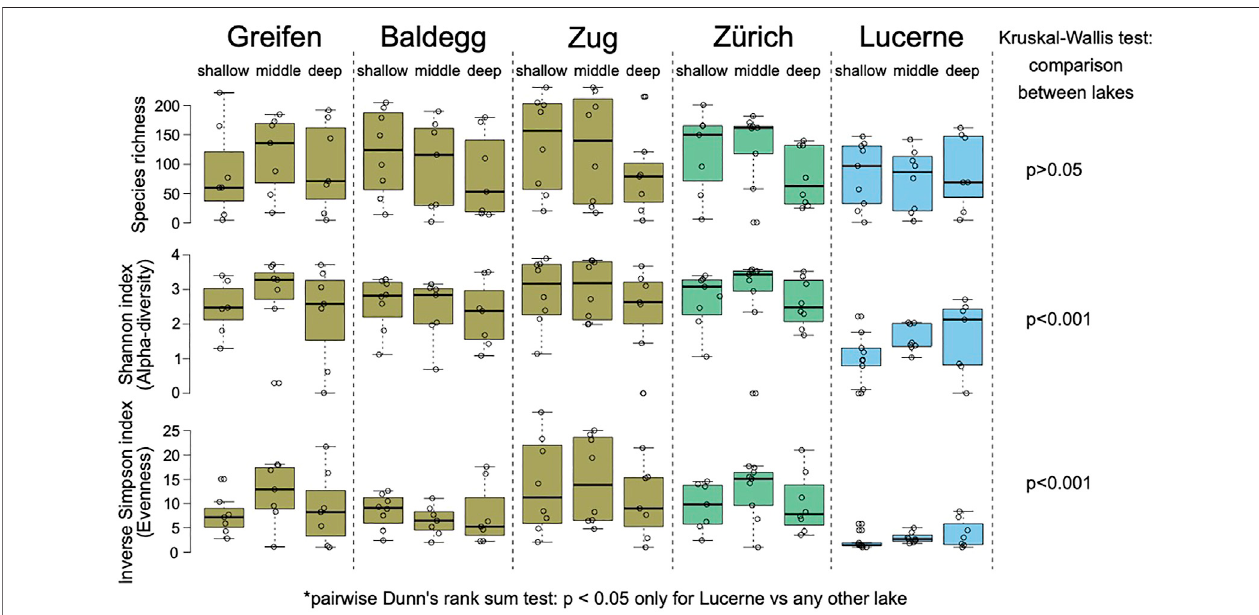
FIGURE4| OTURichness(totalnumberofOTUs),ShannonIndex(diversity),andInverseSimpsonIndex(evenness)of pmo Asequencesacrossthedifferentlakes and samplingstations. Thecolorsrepresent thecurrent trophic states:eutrophic(brown), mesotrophic(green) andoligotrophic(blue). Far right: resultsofKruskal – Wallis testwithDunn ’ sposthoctestshowingthattheShannonandInverseSimpsonIndicesdiffersigni fi cantlybetweenLakeLucerneandtheotherfourlakes,butnotbetween the other four lakes.